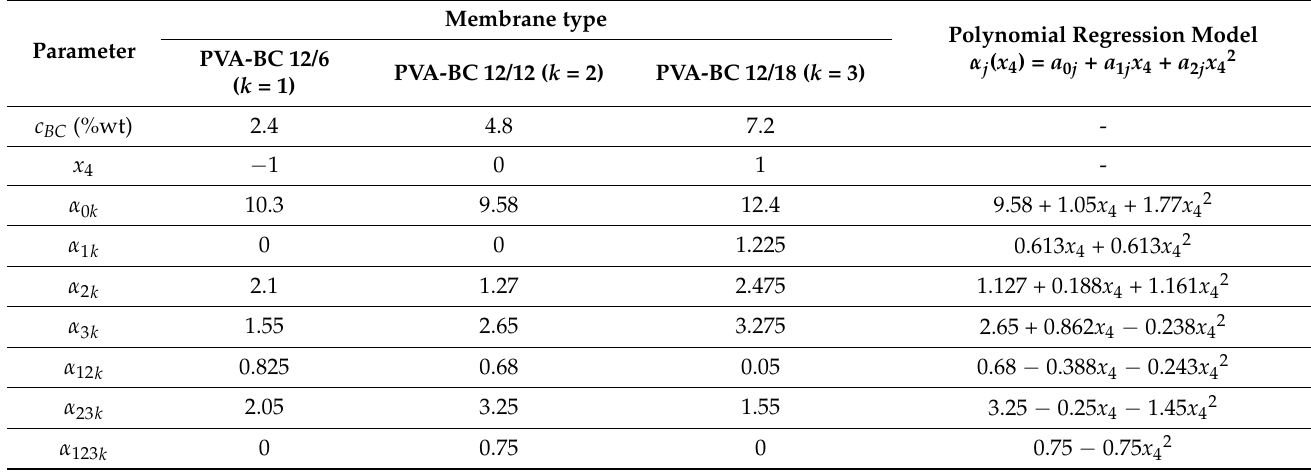
Table 4. Regression coefficients α jk ( j = 0, 1, 2, 3, 12, 23, 123, k = 1..3) depending on BC content in the